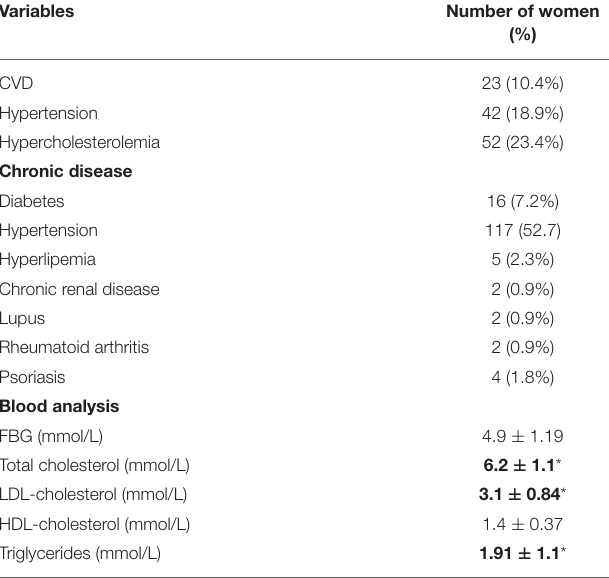
TABLE 1 | Demographic and clinical characteristic of women at Taibah University ( n = 222).